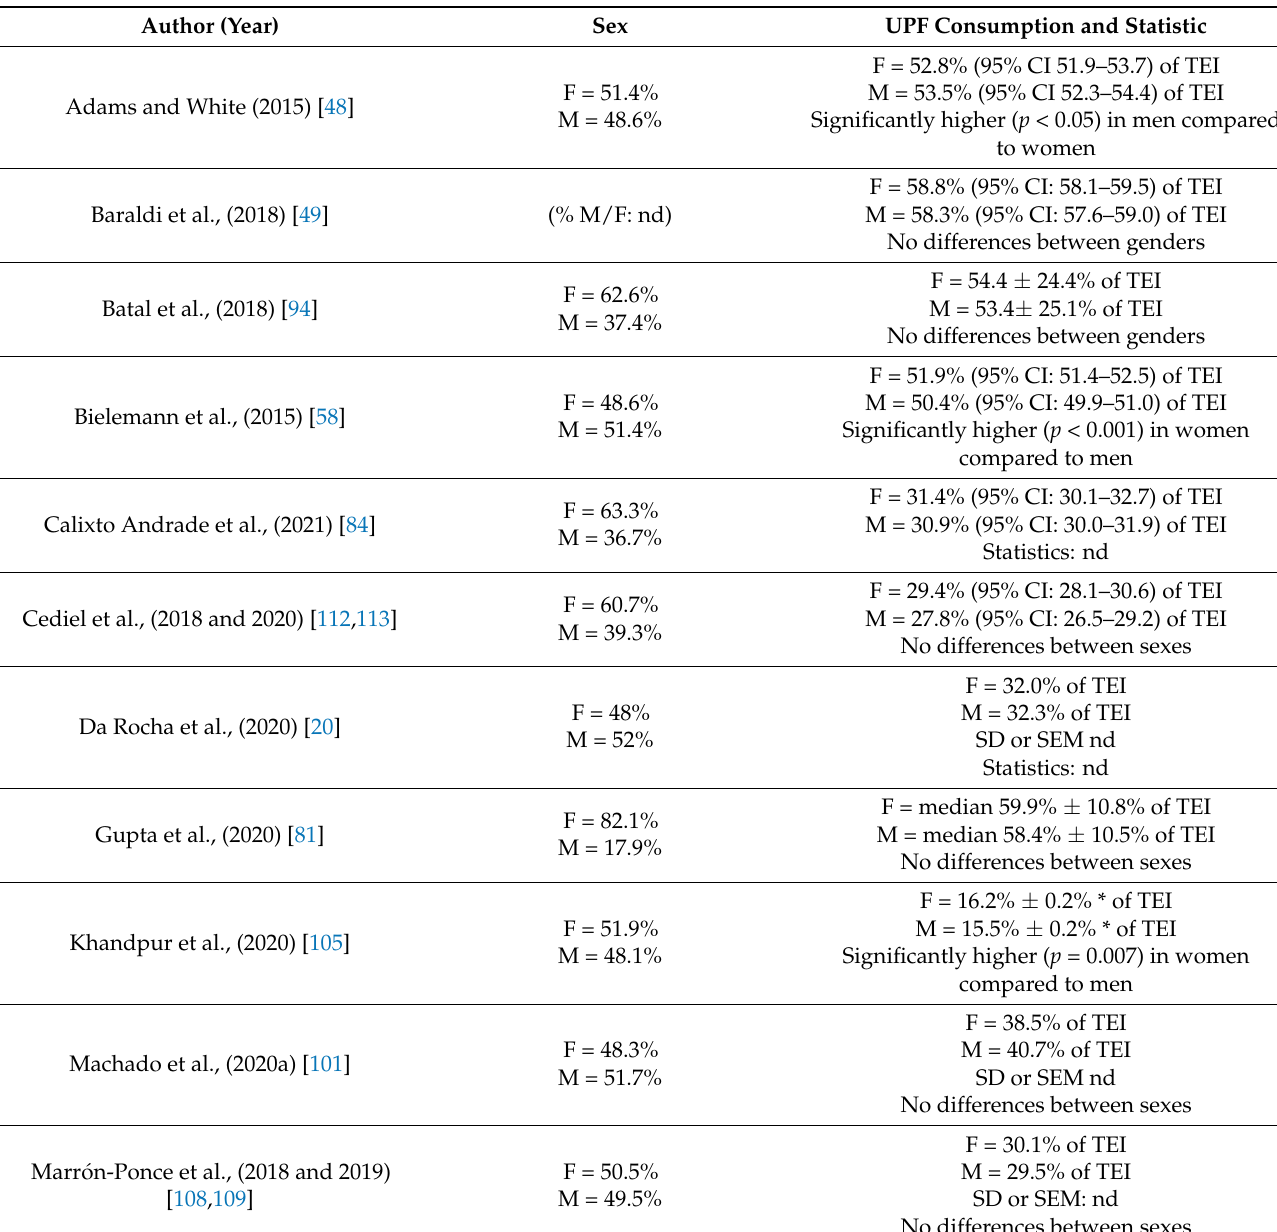
Table 2. Level of consumption of ultra-processed foods (UPF) expressed as percent energy provided by UPF intake with respect to total energy intake (TEI) considering